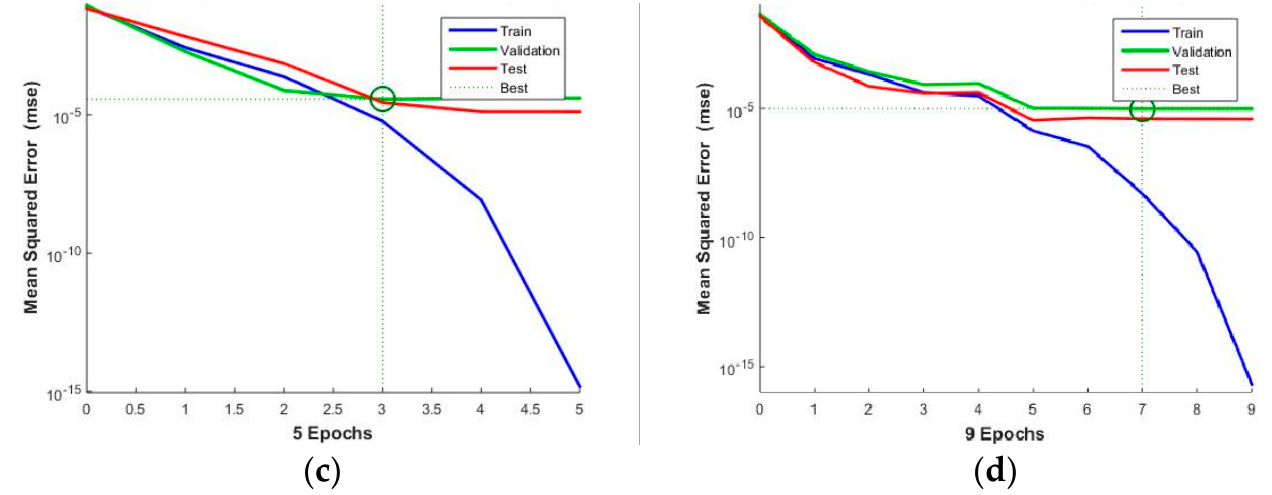
Figure 6. Network training: ( a ) NN1, ( b ) NN2, and ( c ) NN3 for determining the parameters of thickness, expansion, and diffusivity of the TiO 2 thin − film, respectively, and ( d ) NN4 for determining all three data, simultaneously.